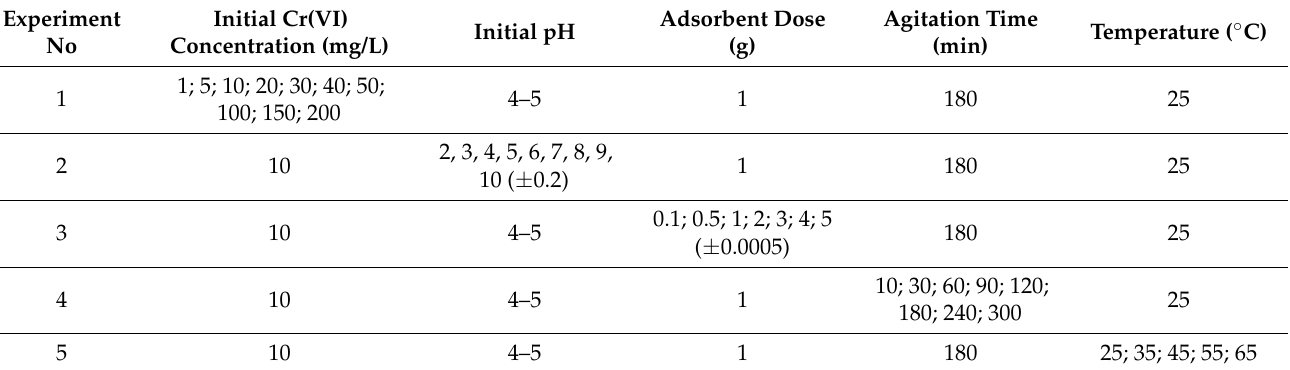
Table 1. Parameters tested for Cr(VI) adsorption using